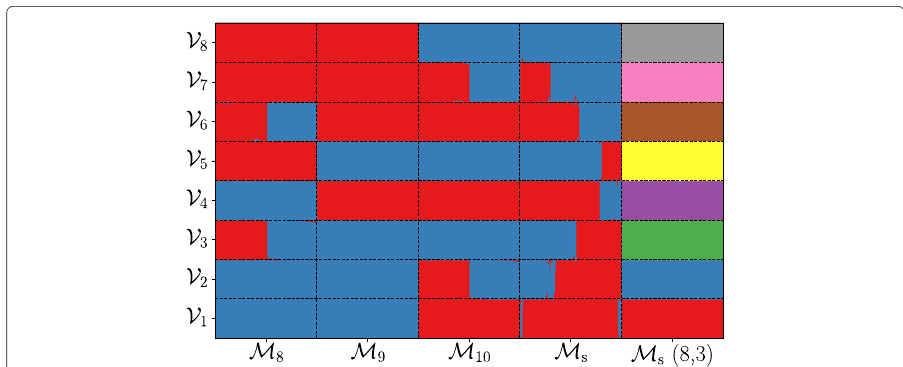
Fig. 18 The detected groups uncovered by each method using structural motifs, with k = 2 and l = 2, with the exception of the last column which has k = 8, l = 3. We test 100 replicates and present the results as columns in the plot. We order and color the columns as in Fig. 7. While the clustering assignments may contain some errors, the results are relatively robust across